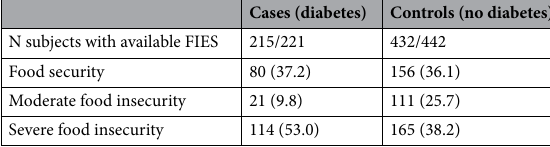
Cases (diabetes) Controls (no